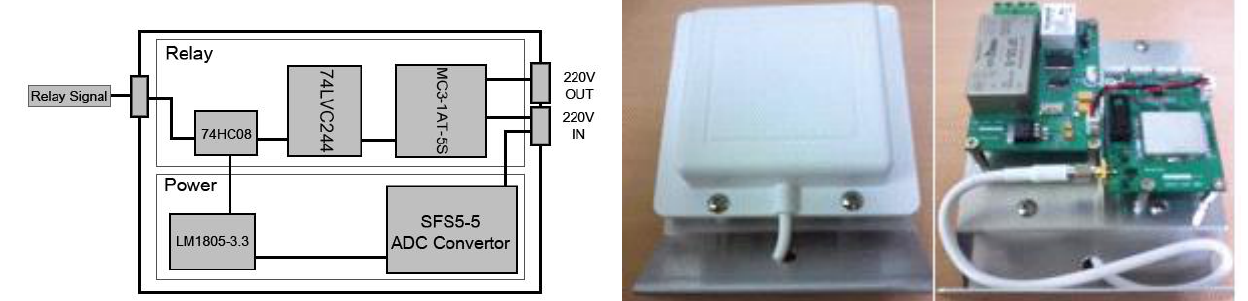
Figure 6. Relay node block diagram and manufactured relay